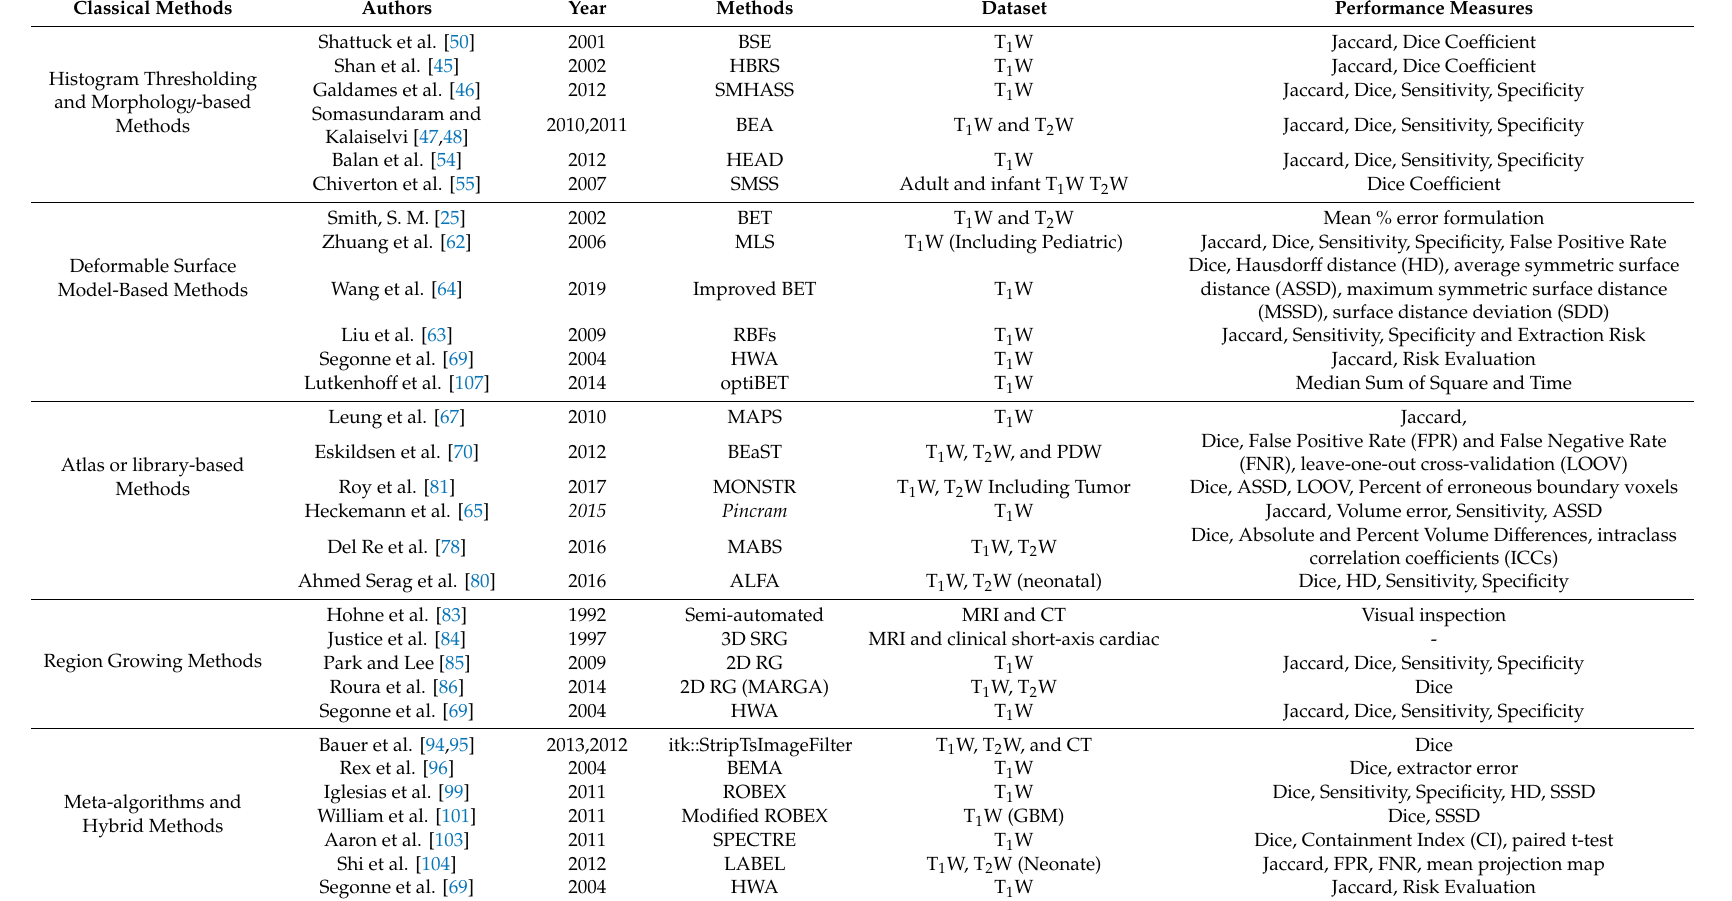
Table 3. Notable conventional skull stripping